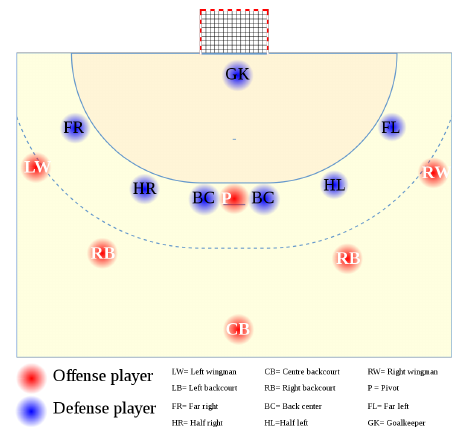
Figure 11. Often used defense (blue) and offense (red) formations in handball. (Source: